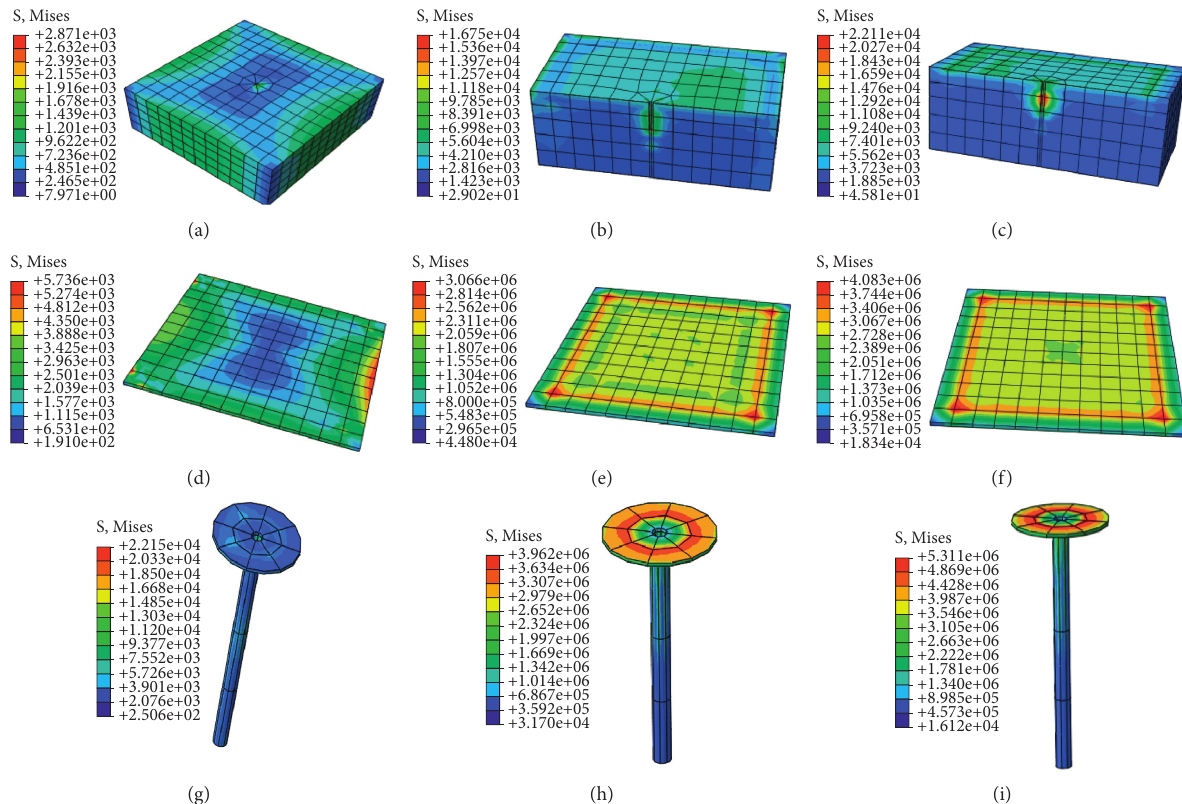
Figure 19: Principal stress distribution of the semirigid finish layer (unit: MPa). (a) Masonry wall (without temperature). (b) Masonry wall (50 ° C). (c) Masonry wall ( − 20 ° C). (d) Bonding layer (without temperature). (e) Bonding layer (50 ° C). (f) Bonding layer ( − 20 ° C). (g) Bushing (without temperature). (h) Bushing (50 ° C). (i) Bushing ( − 20 °